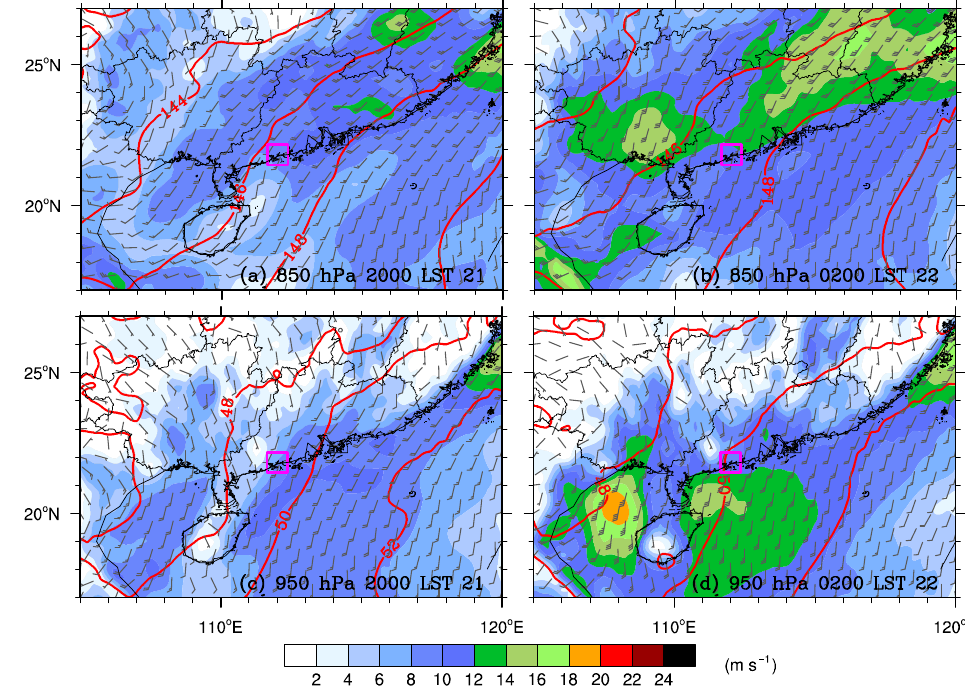
Figure 4. The horizontal wind (barbs and shadings; m s − 1 ) and geopotential height (solid red contours at intervals of 20 gpm) at ( a , c ) 2000 LST on 21 June and ( b , d ) 0200 LST on 22 June 2017 at 850 hPa ( a , b ) and 925 hPa ( c , d ). Purple box indicates the location of the rainfall of interest.